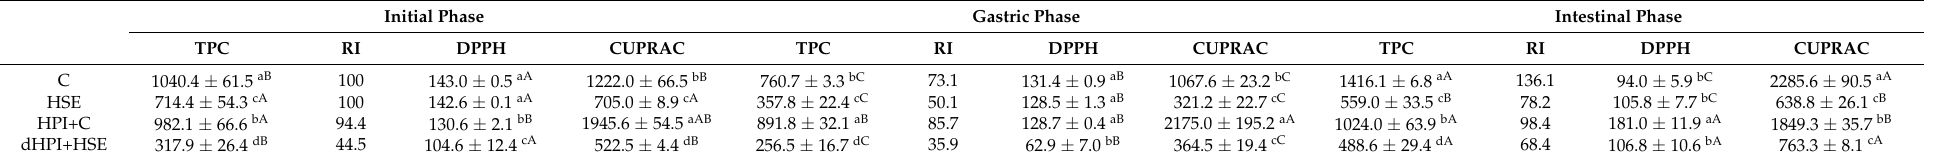
Table 5. Total phenolic content (TPC), recovery index of phenolic compounds (RI), and antioxidant capacities (DPPH and CUPRAC methods) in gastrointestinal digestion